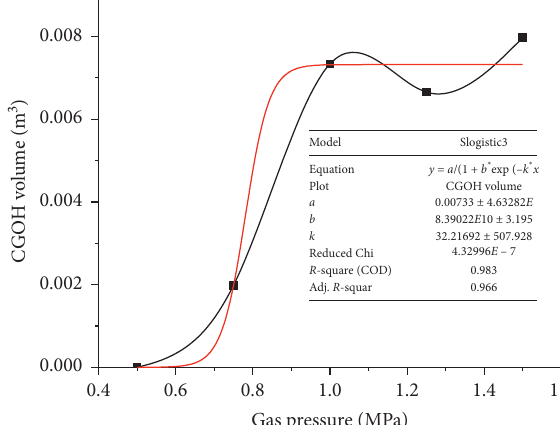
Figure 28: Fitting gas pressure and volume curve with the Slogistic3